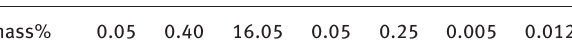
Table 1: Chemical composition of Fe-16Cr alloy. Elements